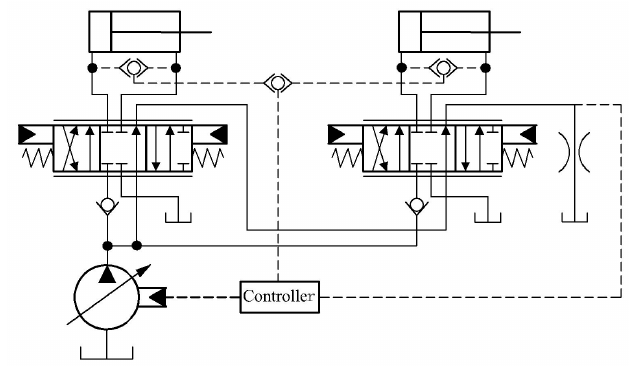
Figure 6. Negative flow load sensitive control system.